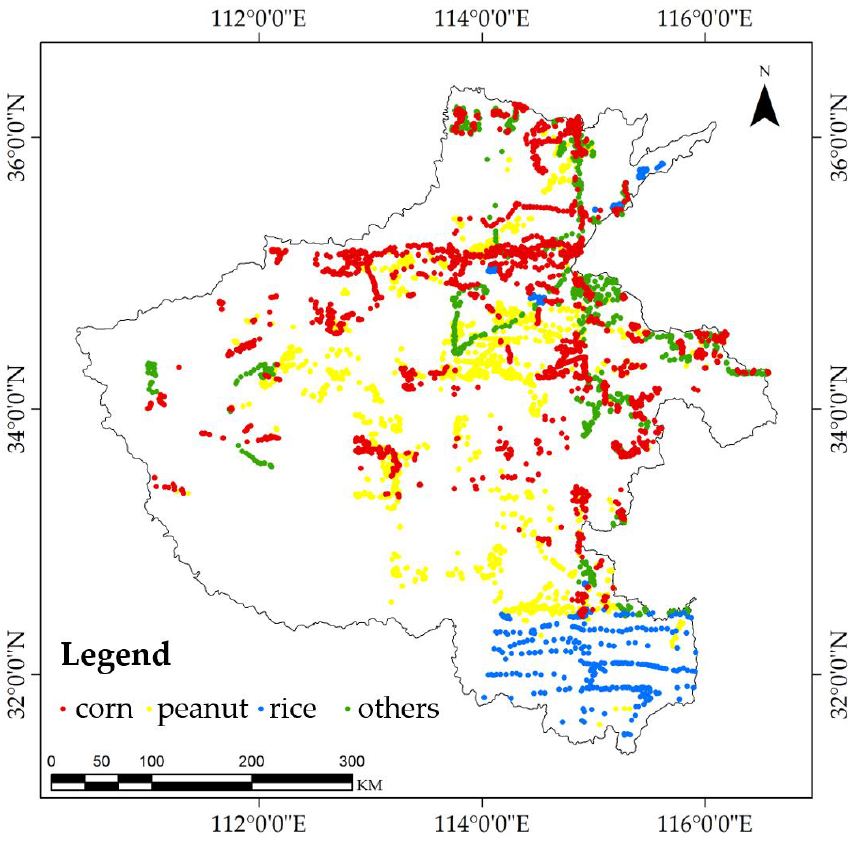
Figure 4. Distribution of sample points in the study area.